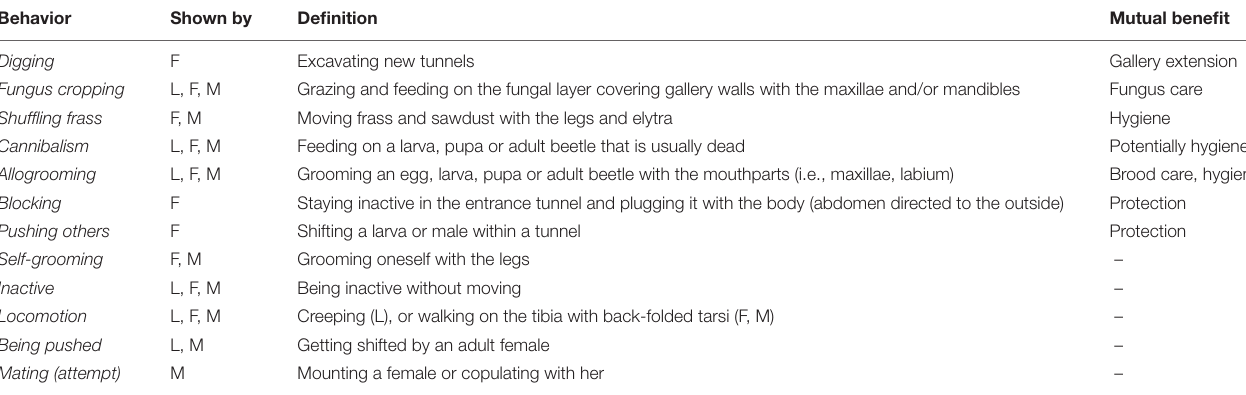
TABLE 1 | Ethogram of the observed behaviors of X. affinis larvae (L), females (F), and males (M) (modified from Biedermann and Taborsky,